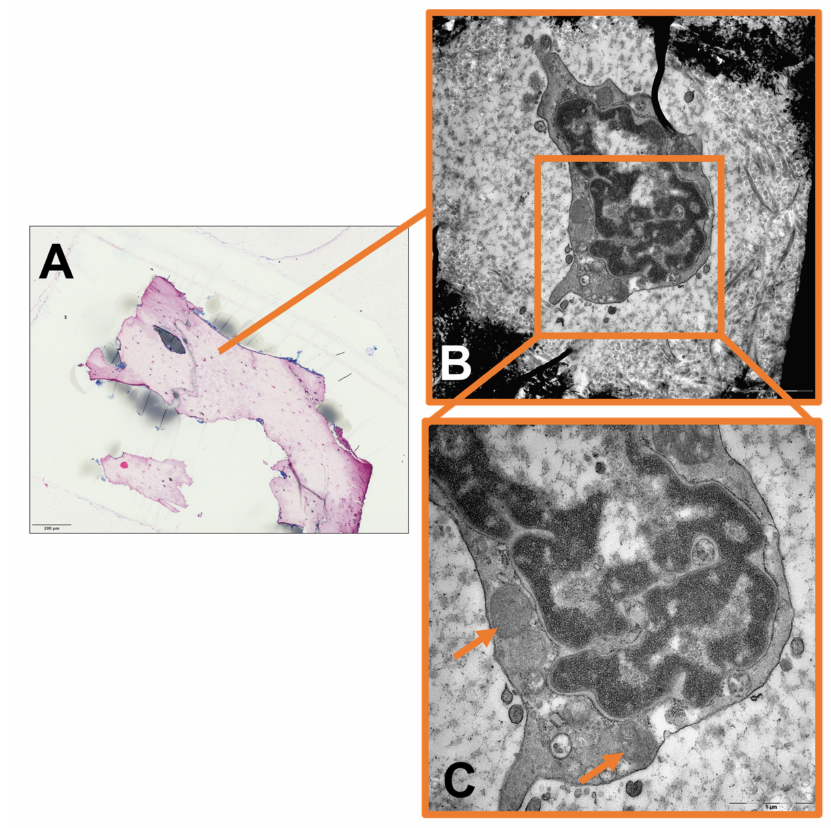
Figure 4. ( A ) Light microscopy image of non-infectious bone for comparison (magnification × 40). ( B ) Magnification of ( A ). Transmission electron microscopy image of non-infectious osteocyte (magni- fication × 5000). ( C ) Magnification of ( B ). Transmission electron microscopy image of perinuclear region of osteocyte. Visible solitary mitochondria with sustained cristae and matrix density indicated by arrows (magnification ×